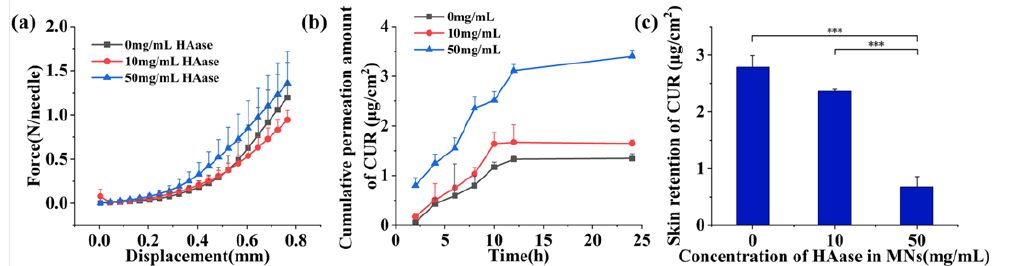
Figure 4. ( a ) Force–displacement curves, ( b ) Cumulative permeation and ( c ) Skin retention of CUR in MNs with different HAase concentrations. (Significance is denoted in the figure as *** p < 0.001).